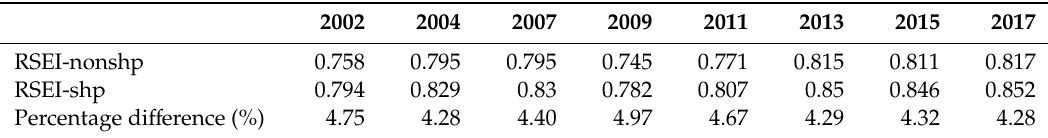
Table 6. Comparison between RSEIs computed with and without sharpened